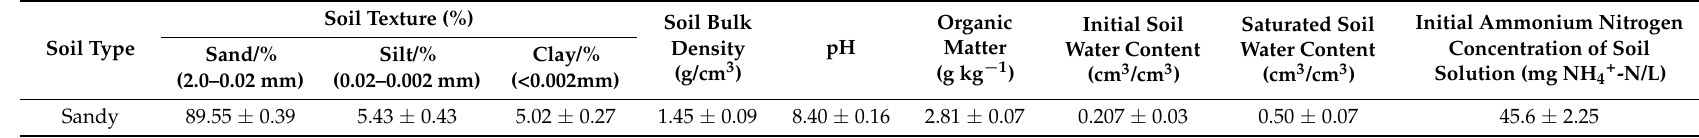
Table 1. Soil physical and chemical properties of soil samples collected from the study area (mean ± deviation